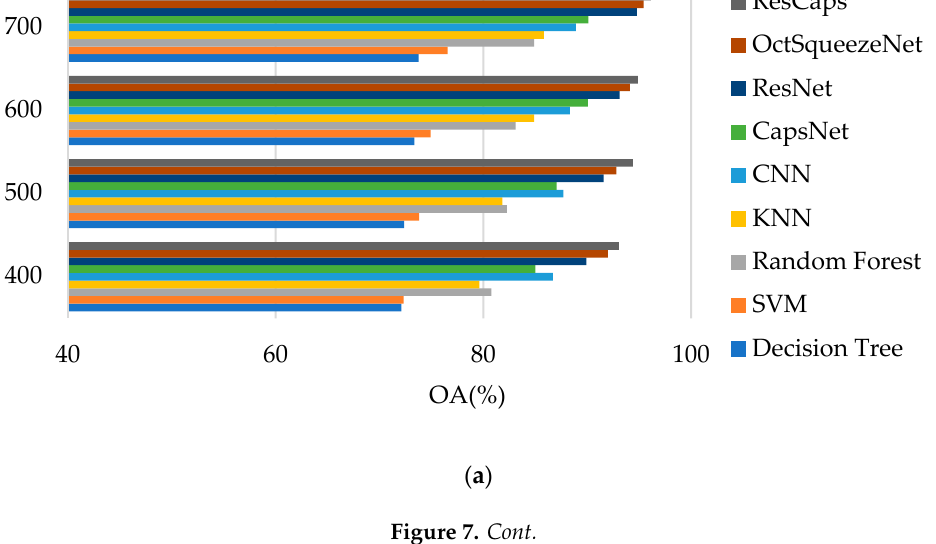
Table 5. Precision and recall of each class for 700 samples on Recology data